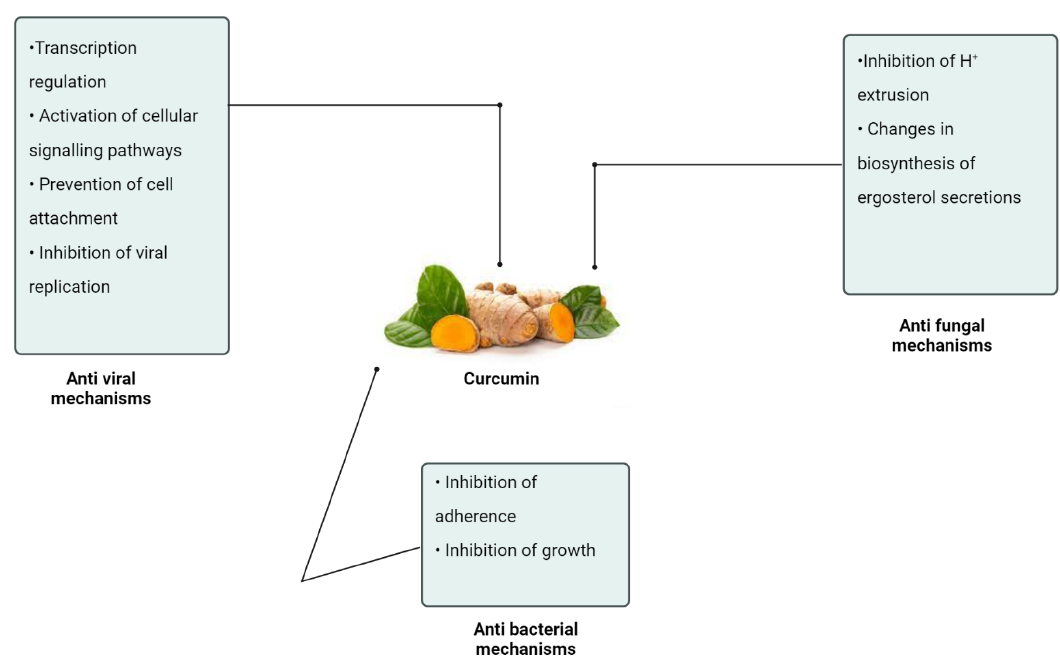
Figure 4. Antimicrobial mechanisms of